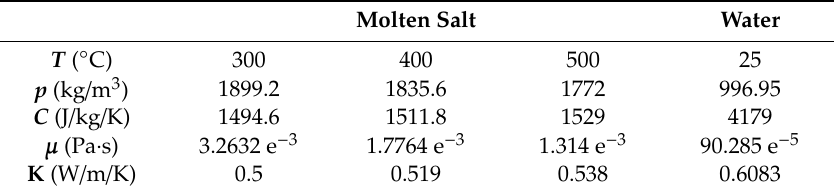
Table 2. Physical property parameters of water and molten salt at di ff erent temperatures.